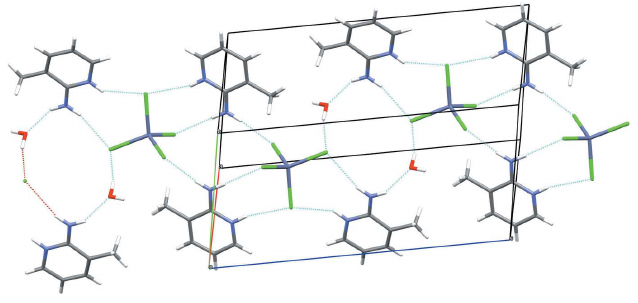
Figure 12 The unit-cell packing in (V) viewed approximately down [101]. Hydrogen bonds are shown as dashed